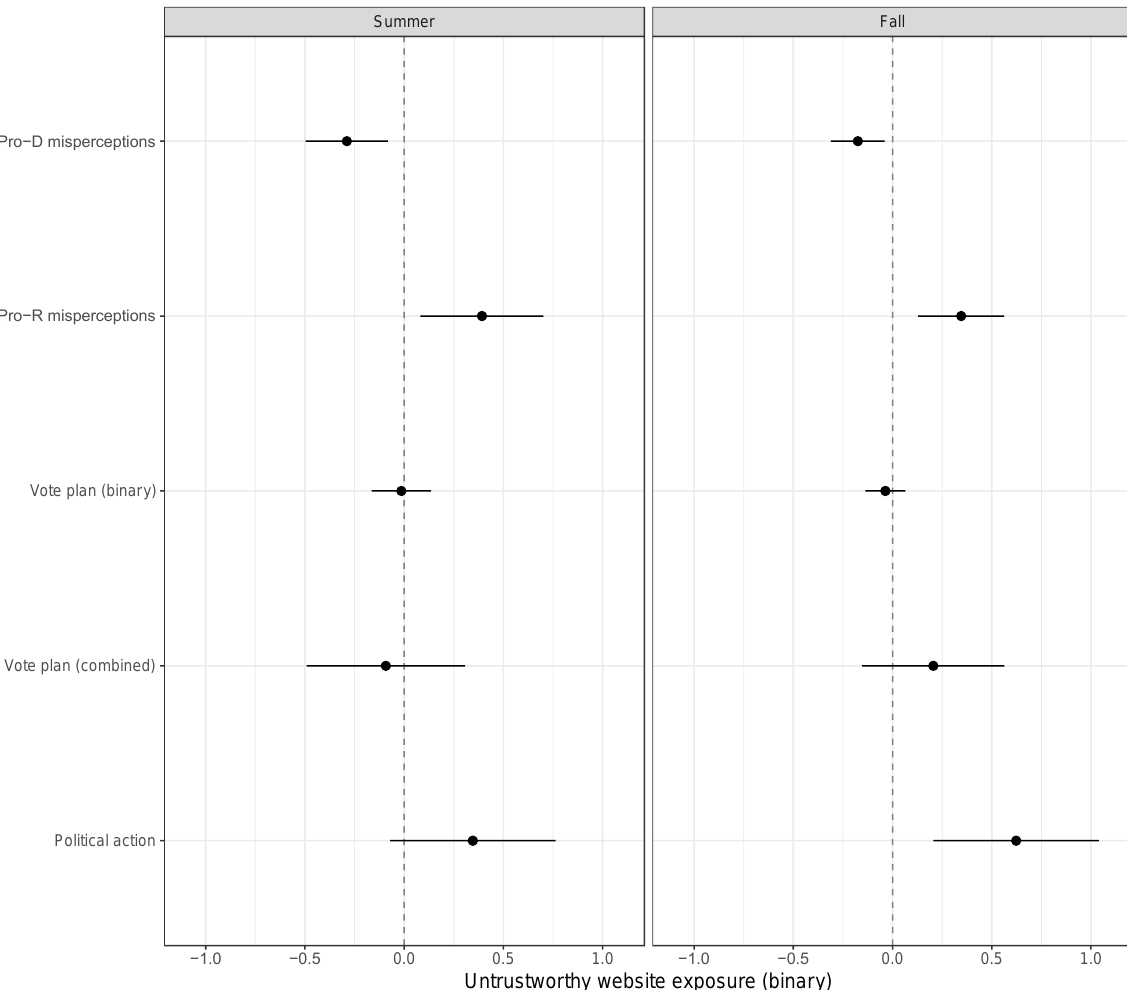
Figure 2. Association between untrustworthy website consumption and beliefs/behavior. Change in misperceptions, vote intentions, and willingness to take political action associated with consumption of news from untrustworthy websites. Point estimates (with 95% confidence intervals) from separate OLS regressions. Outcome measures are average belief in pro- Democratic or pro-Republican misperceptions on a four- point accuracy scale ranging from “Not at all accurate” (1) to “Very accurate” (4); whether respondents say they are “absolutely certain” to vote or report already having voted (0/1); a five -point measure of vote intention ranging from answering no when asked if they plan to vote (1) to saying they are “absolutely certain” to vote or report already having voted (5); and respondents’ average response when asked if they would be willing to take a series of political actions on a scale from “Disagree strongly” (1) to “Agree strongly” (5). Control variables include partis anship, ideology, political knowledge, feelings toward President Trump, age, race, and college education. See Tables B3 and B4 for full results. Note: Voting and participation regressions are estimated among respondents in the control condition for the false article